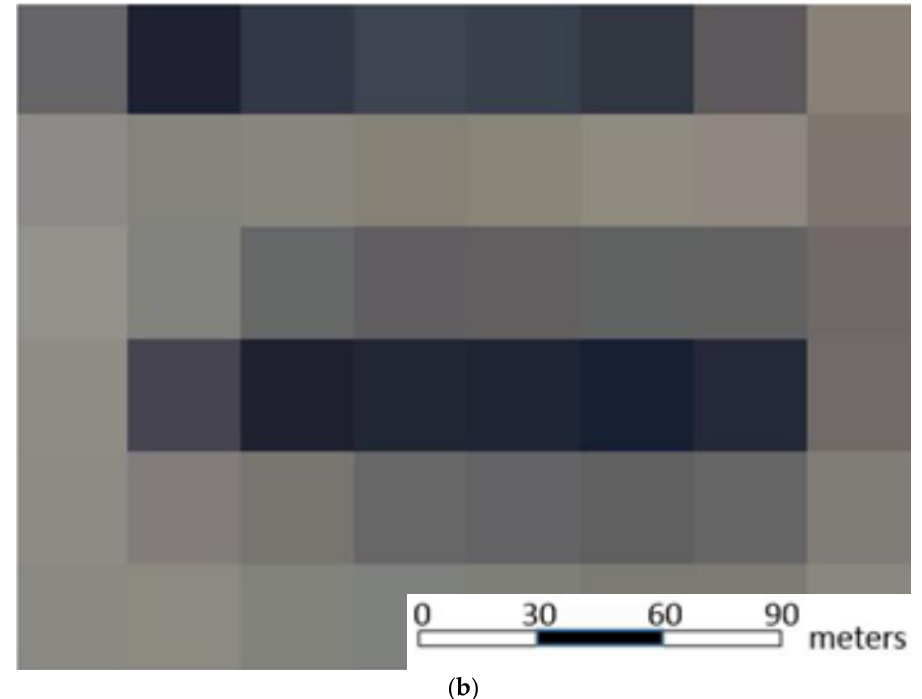
Figure 2. ( a ) Image of a rangeland study area acquired with a Phantom 4 sUAS flying at 120 m AGL with a spatial resolution of 6 cm per pixel. ( b ) Same scene resampled to 30 m resolution with six rows and eight columns of pixels [22].